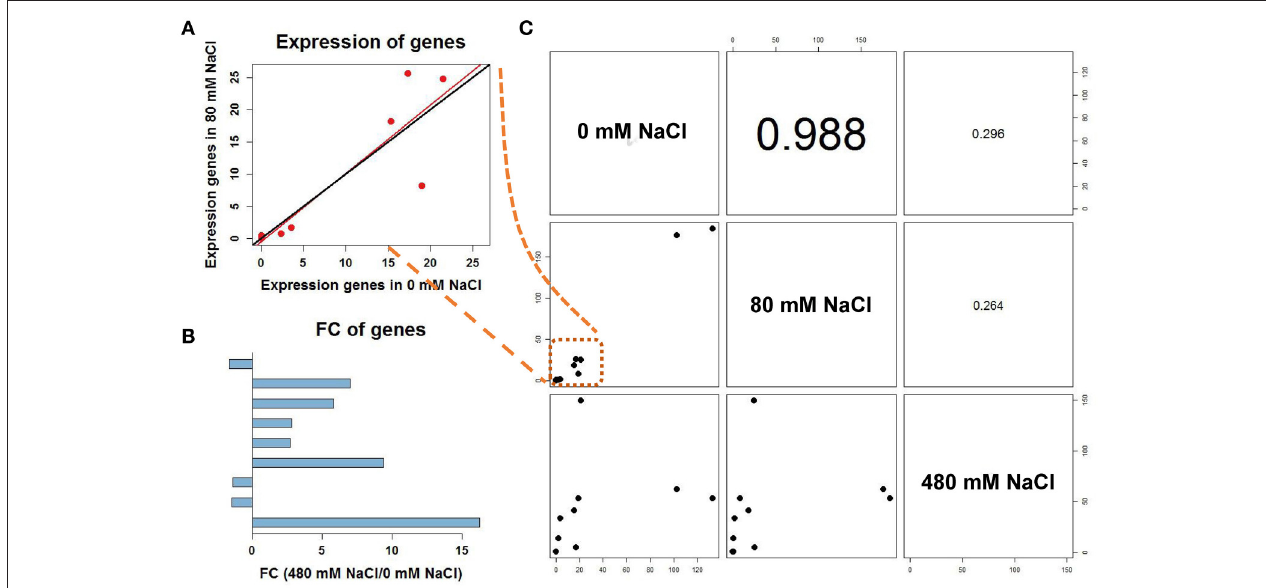
FIGURE 6 | Correlation analyses among different treatments of differentially expressed unigenes involved in alanine, proline and sucrose metabolism. (A) The scatter plot of the seven genes in C was magnified. The fit line (red) between control and low salinity was close to the y = x line (black). (B) Fold change of differentially expressed genes under the 480-mM NaCl treatment to 0mM NaCl. Up-regulated genes are shown to the right and down-regulated genes to the left. (C) Correlation coefficients for the expression levels of differentially expressed unigenes among different treatments.